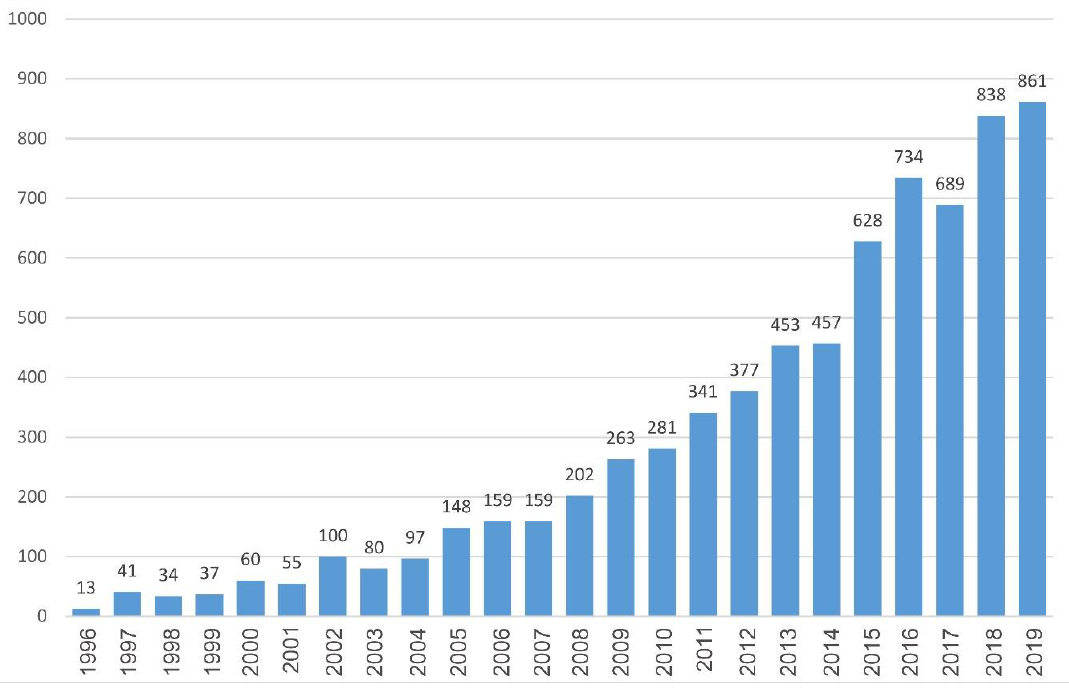
Figure 1. Bar chart of the time evolution of scientific-technical publications (records) on Flood Risk Assessments (FRA) in the Web of Science (WoS) database (search: “flood” AND “risk” AND “assessment”), from 1996 to 2019 [5].